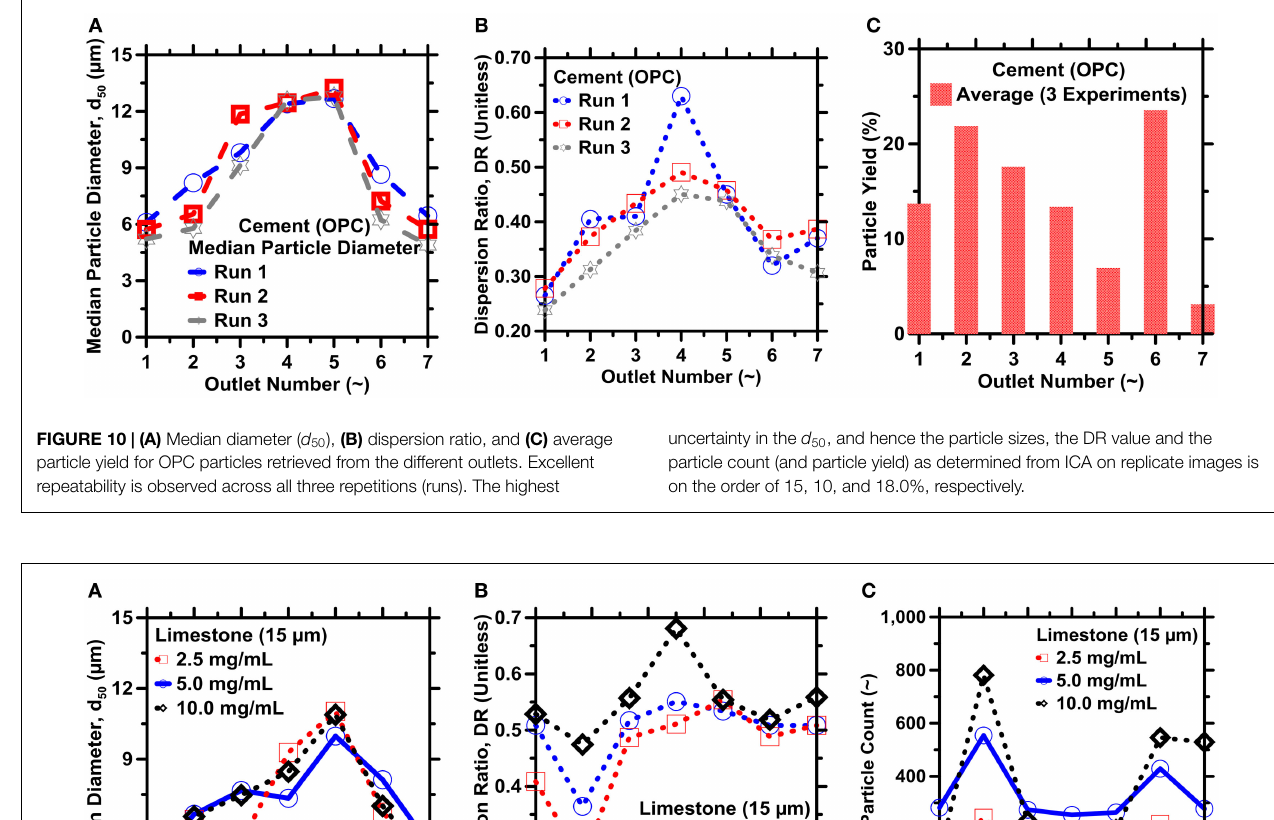
FIGURE 11 | (A) Median particle diameter, (B) dispersion ratio, and (C) particle yields at the different outlets for different solid loadings. The solid used was limestone; for dilutions indicated in the legends. The highest uncertainty in d 50 , DR, and particle yield as determined from ICA on replicate images are on the order of: 4, 9, and 10.5%, respectively.